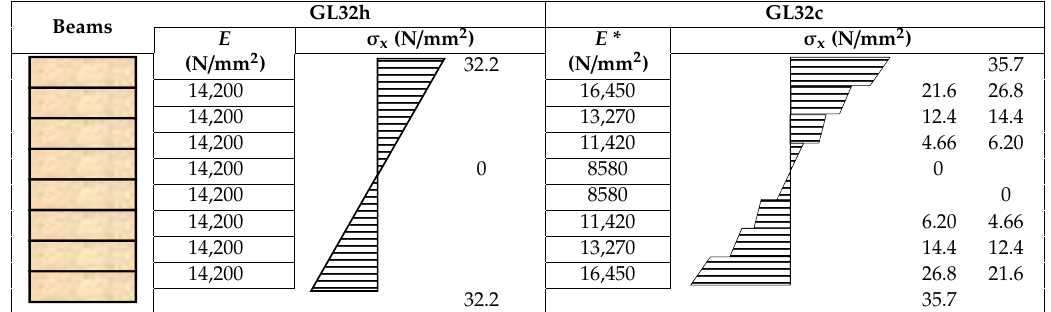
Table 4. Modules of elasticity of individual layers for beams of the Gl32h (homogeneous) and GL32c (combined) type and their stress diagrams.